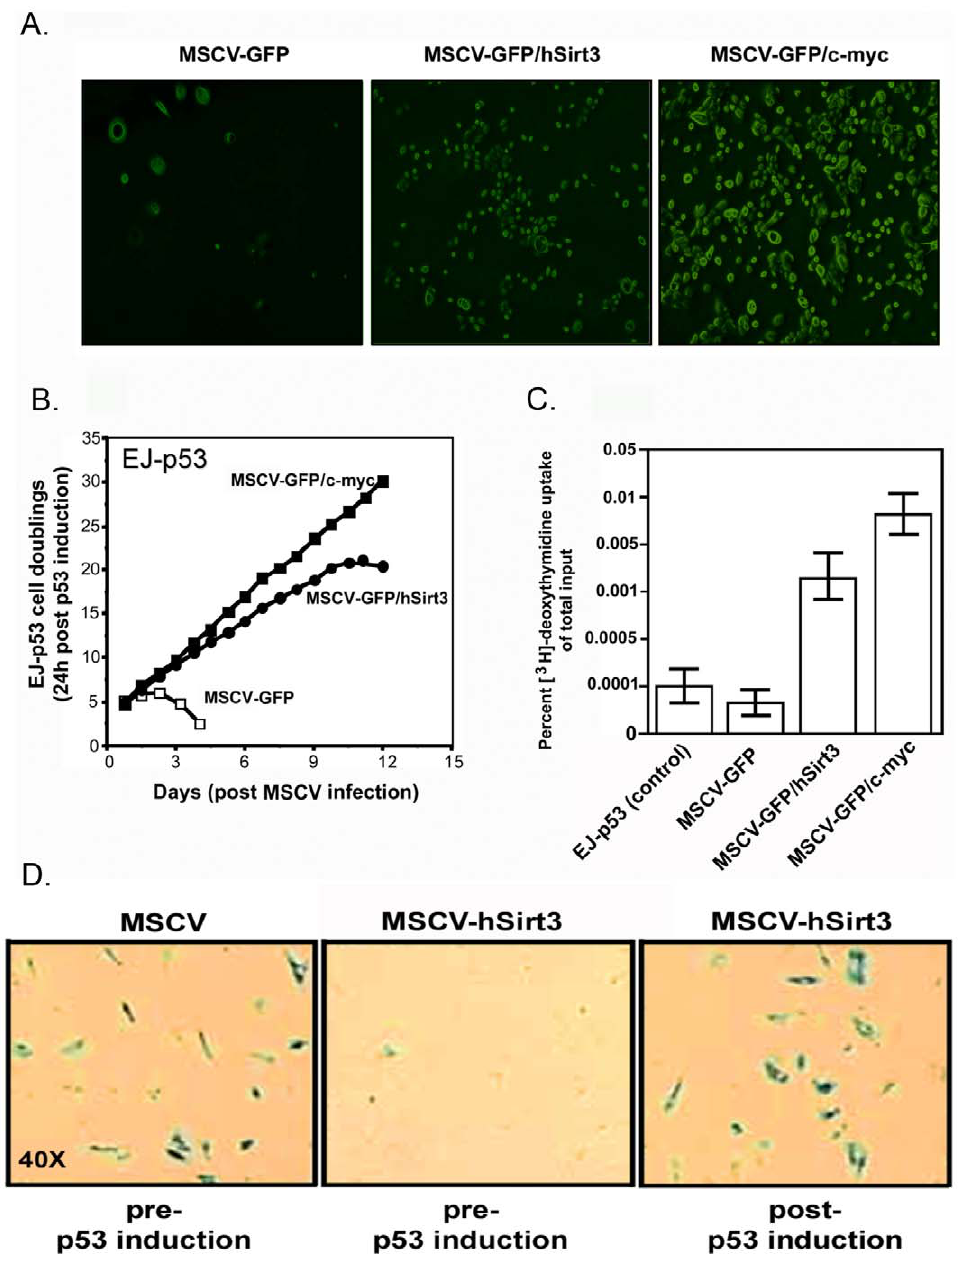
Figure 3. The NAD + -dependent Sir2 -like mitochondria protein deacetylase, SirT3, rescues EJ-p53 from p53 –inducible growth arrest. The human SirT3 2.9 kb cDNA identified in the retroviral screen ( Fig. 2 ) was placed in the MSCV retroviral plasmid using a bicistronic cassette with GFP (Green fluorescent protein). EJ-p53 cells were transduced with MSCV particles containing only GFP, mouse c-myc and human SirT3. Cell growth kinetics were determined by laser scanning florescence microscopy ( A ) and by monitoring cell populations ( B ). ( C ) [ 3 H]-thymidine incorporation studies were assayed after 72 hours in EJ-p53 cells following transduction with indicated retroviruses followed by induction of p53 expression by tetracycline withdrawal for 72 hours. ( D ) SA- b galactosidase activity were determined in retroviral transduced EJ-p53 with MSCV-GFP/ Sirt3 transduced into EJ-p53 cells prior and following induction of p53 by tetracycline withdrawal. doi:10.1371/journal.pone.0010486.g003 function as sensors of metabolic or oxidative states of cells and regulate cellular functions accordingly. Mammalian SirT1, which resides in the nucleus, is the most closely related to yeast Sir2 and SirT3 is most closely related to SirT1 [8]. SirT1 binds and